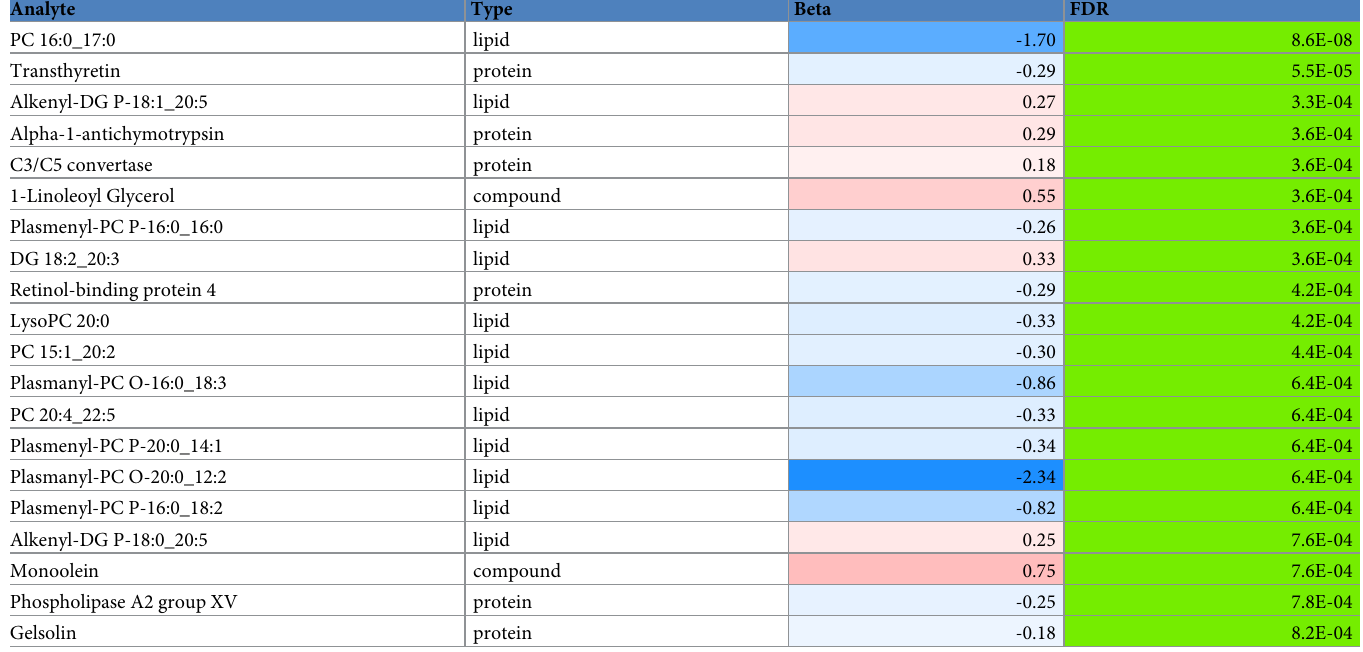
Table 3. Top proteins and metabolites with the greatest associations in pregnant participants with severe COVID-19.